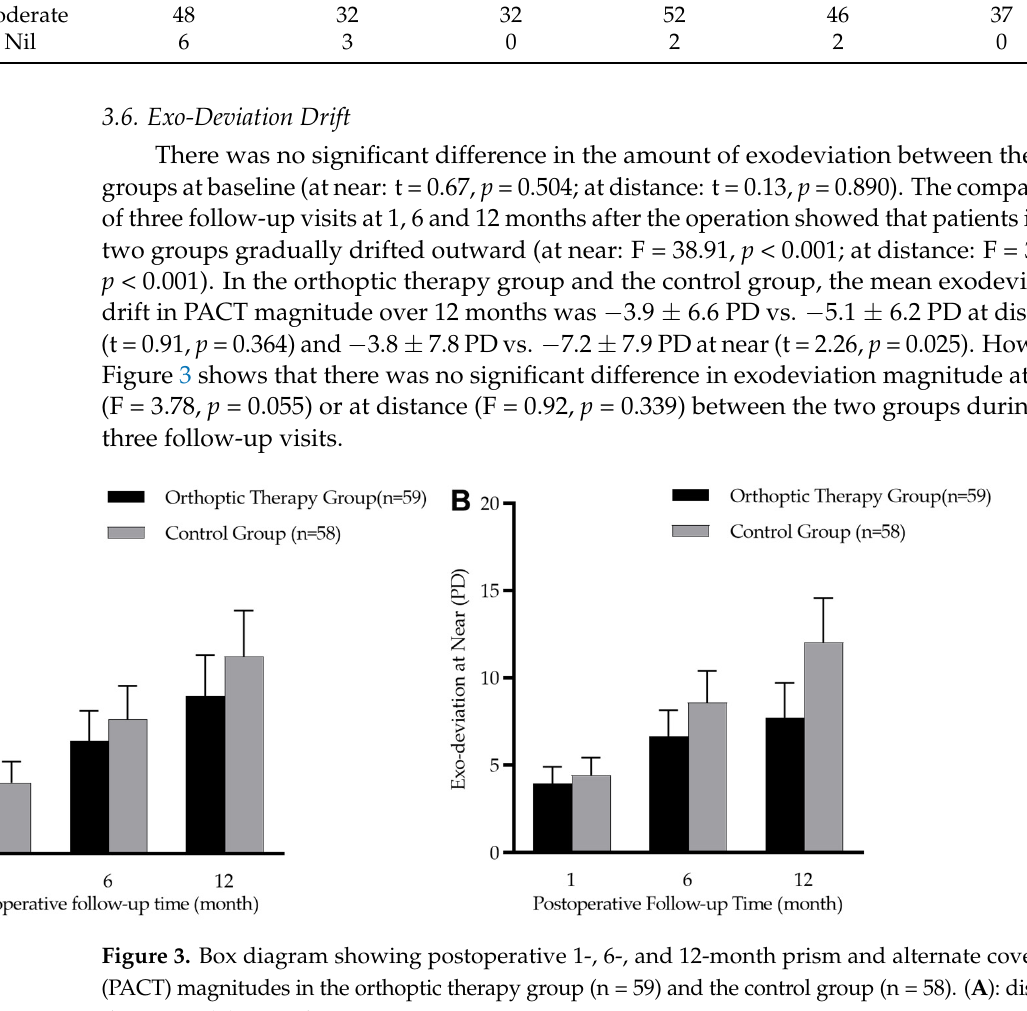
Table 5. Fusional Exotropia Control Score by 12 months in the orthoptic therapy group and the control group.